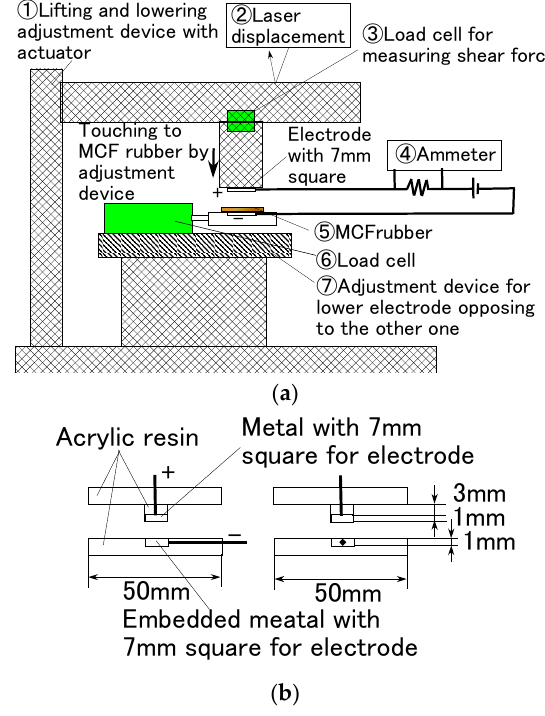
Figure 7. Schematic diagram of experimental apparatus used to investigate the electric characteristics